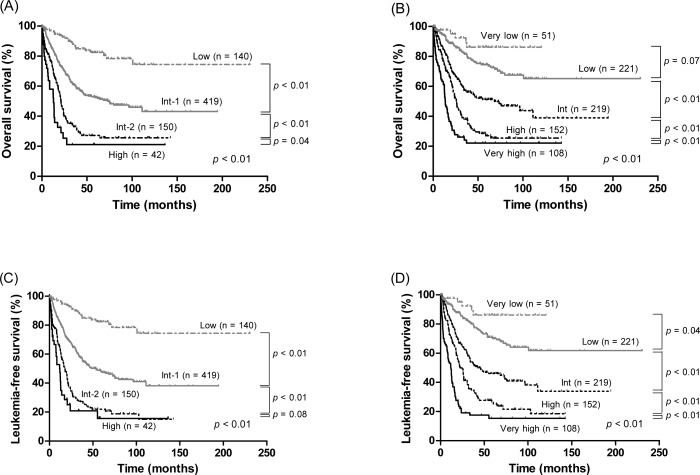
Kaplan-Meier survival curves of overall survival (A and B) and leukemia-free survival (C and D) in 751 patients with primary MDS stratified by IPSS and IPSS-R.